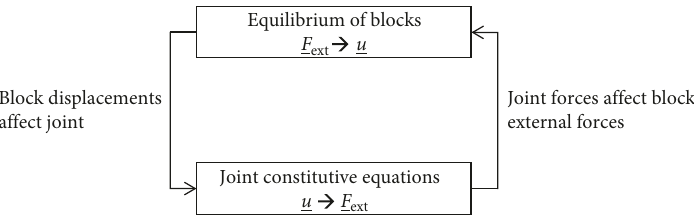
Figure 13: DEM solution scheme at each time step: the solver loops until u and F